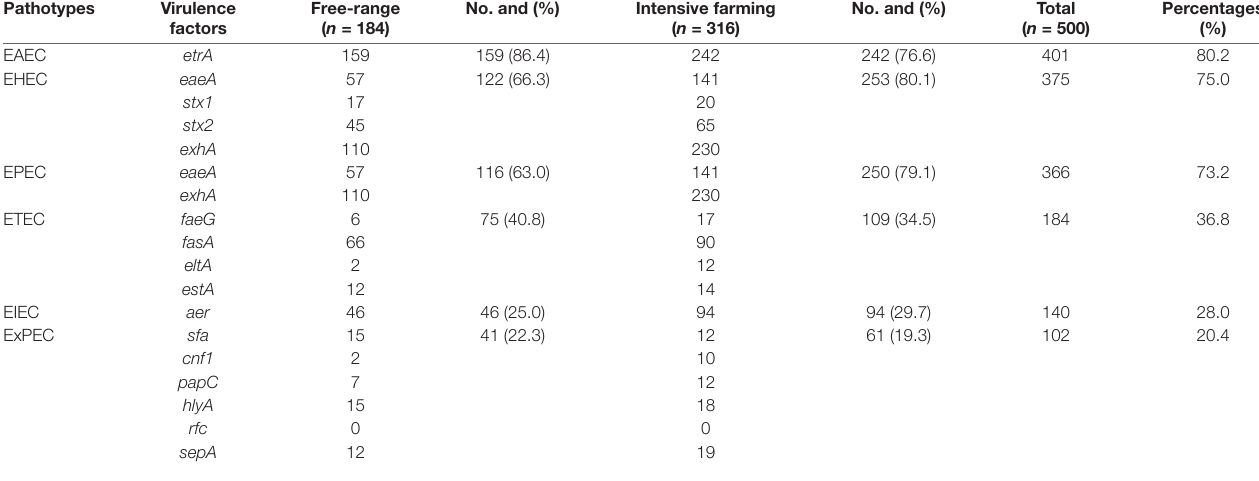
TABLE 3 | The percentage prevalence of the different pathotypes between intensive farming and free-range sheep.